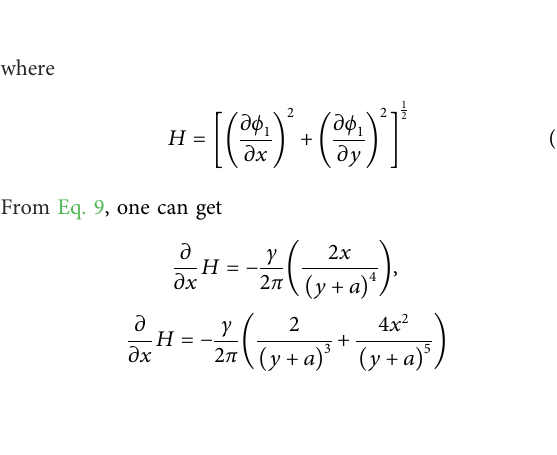
FIGURE 4 Impact of the volume fraction parameter on f ′ ( η ) .